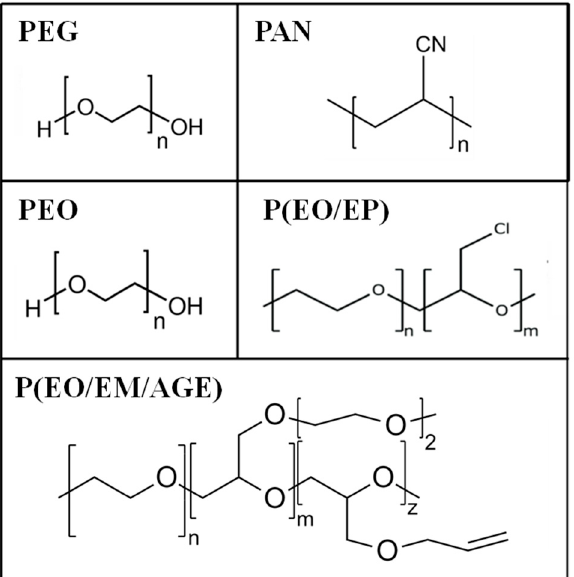
Figure 2. Chemical structures of poly(ethylene glycol) (PEG), polyacrylonitrile (PAN) poly(eth- ylene oxide) (PEO), and PEO based